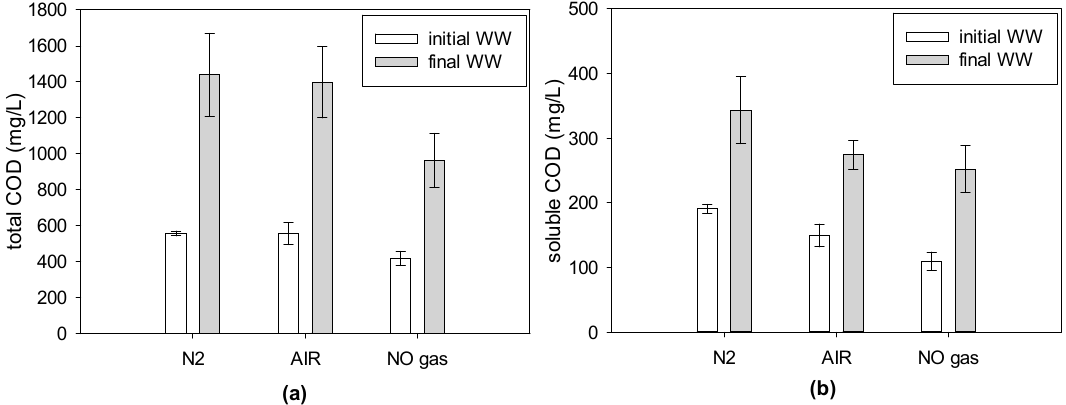
Figure 7. Initial and final WW COD concentration: Total COD ( a ); soluble COD ( b ).